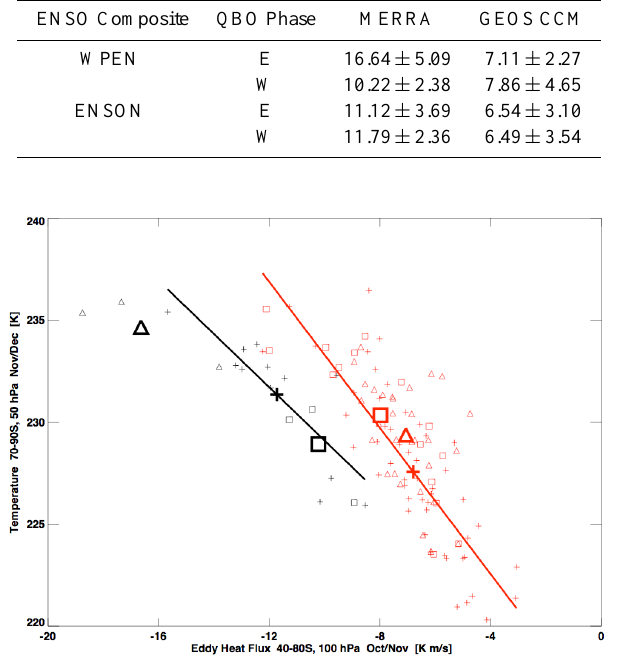
Fig. 3. Scatter plot of October/November meridional eddy heat flux at 40–80 ◦ S, 100hPa versus November/December temperature in the Antarctic polar cap at 50hPa. Red symbols show model re- sults, while black symbols show the MERRA reanalysis. Triangles represent WPEN/QBO-E years; squares represent WPEN/QBO-W years; crosses represent ENSON years. The large symbols show the composite mean values. The red (black) line indicates the linear fit for the modelled (MERRA) ENSON